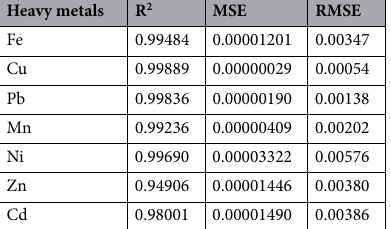
Table 6. Summary of error computation for model